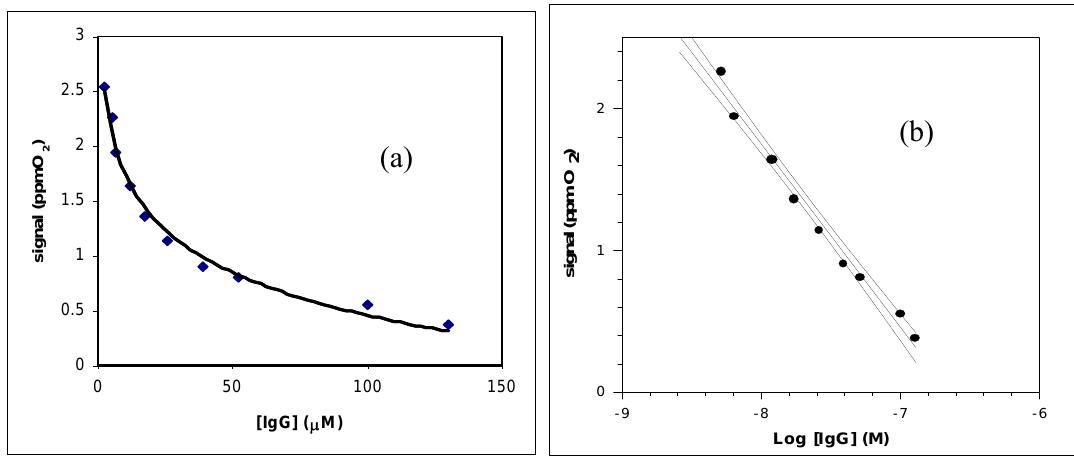
Figure 7. (a) Behaviour of the IgG immunosensor response as a function of increasing IgG concentration using Immobilon membrane and tyrosinase biosensor as a transducer; (b) corresponding calibration curve and confidence interval for IgG